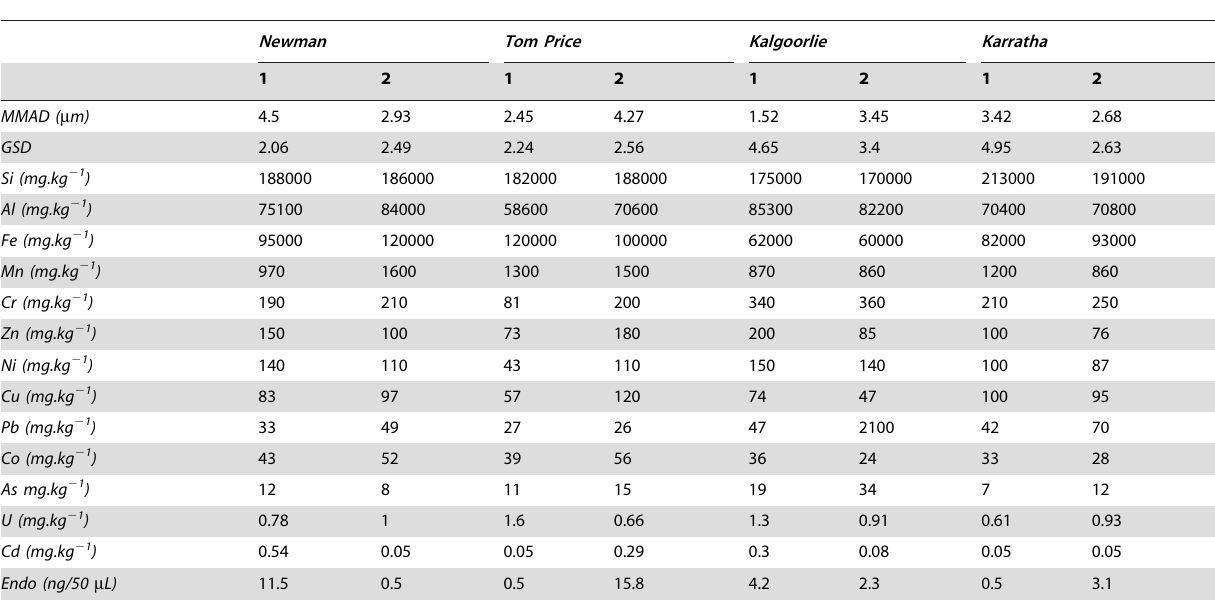
Table 2. Summary of the physico-chemical characteristics of the geogenic PM 10 from each of the